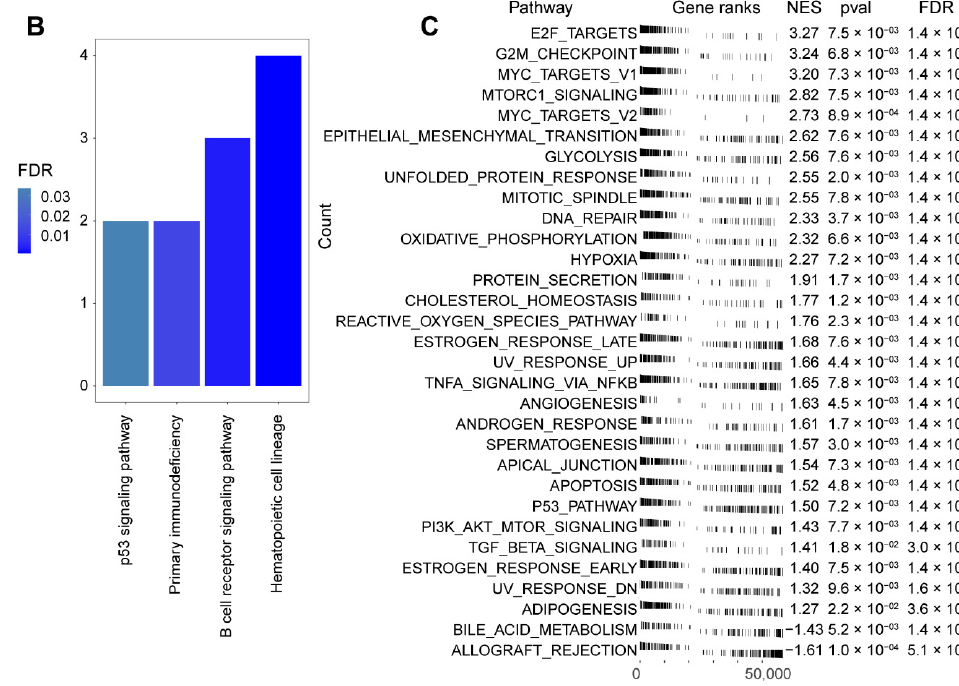
Figure 5. Enrichment analysis results relevant to TMERSscore. ( A ) Gene ontology analyses of the DEGs. ( B ) KEGG analyses of the pathways of the DEGs. ( C ) GSEA of TMERSscore demonstrates the activation pathways of different subgroups.